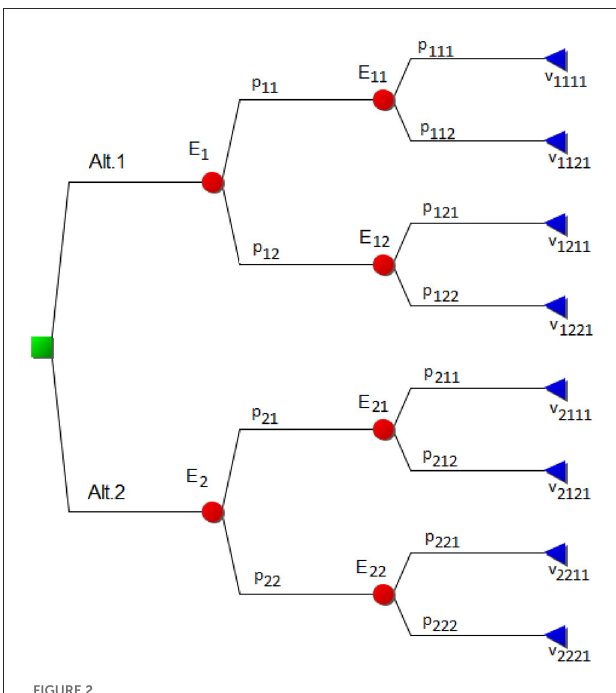
FIGURE2 A decision tree with two